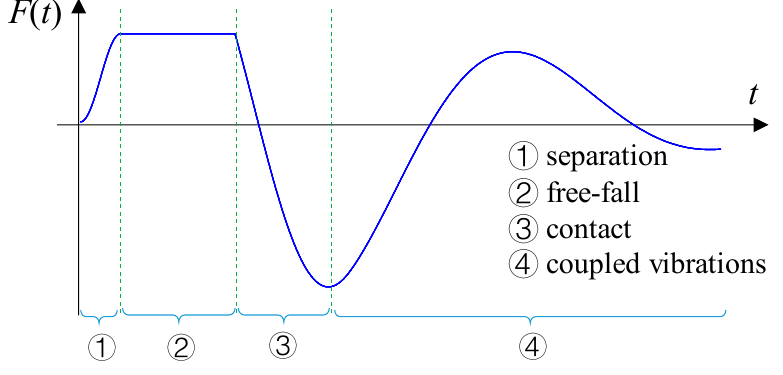
Figure 3. Diagram of vehicle bump on a bridge using a 4 ‐ DOF vehicle model.